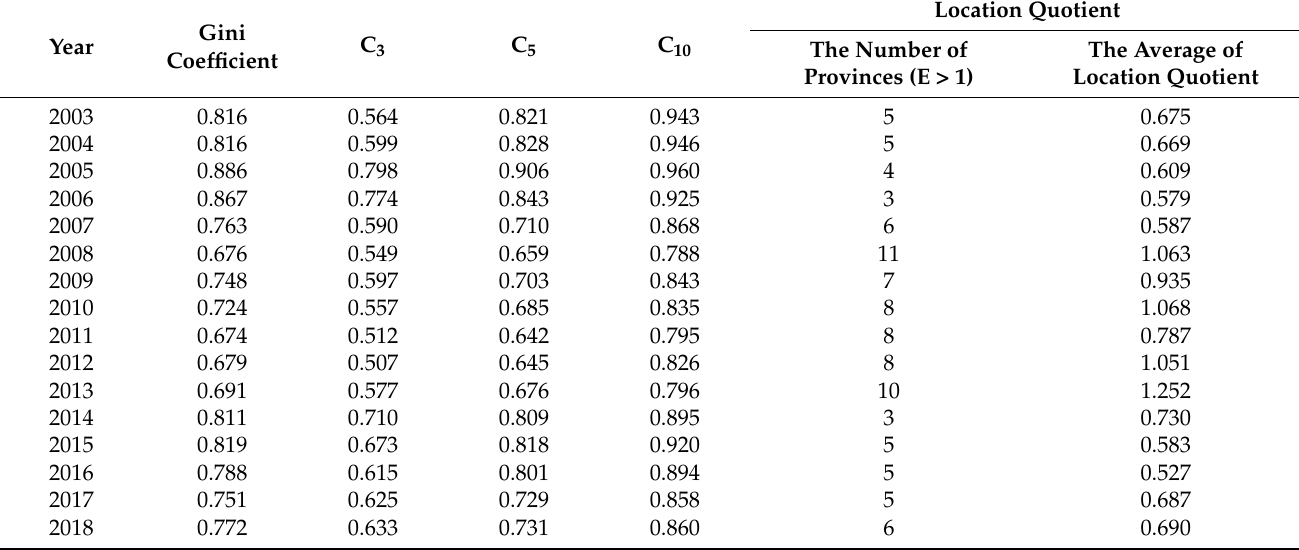
Table 2. Gini coefficient, location quotient, and concentration coefficient of venture capital in